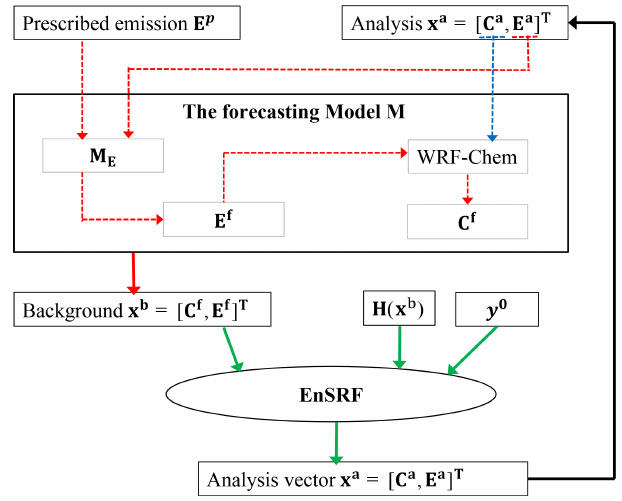
Figure 1. Flow chart of the data assimilation system that simulta- neously optimizes the initial chemical conditions and